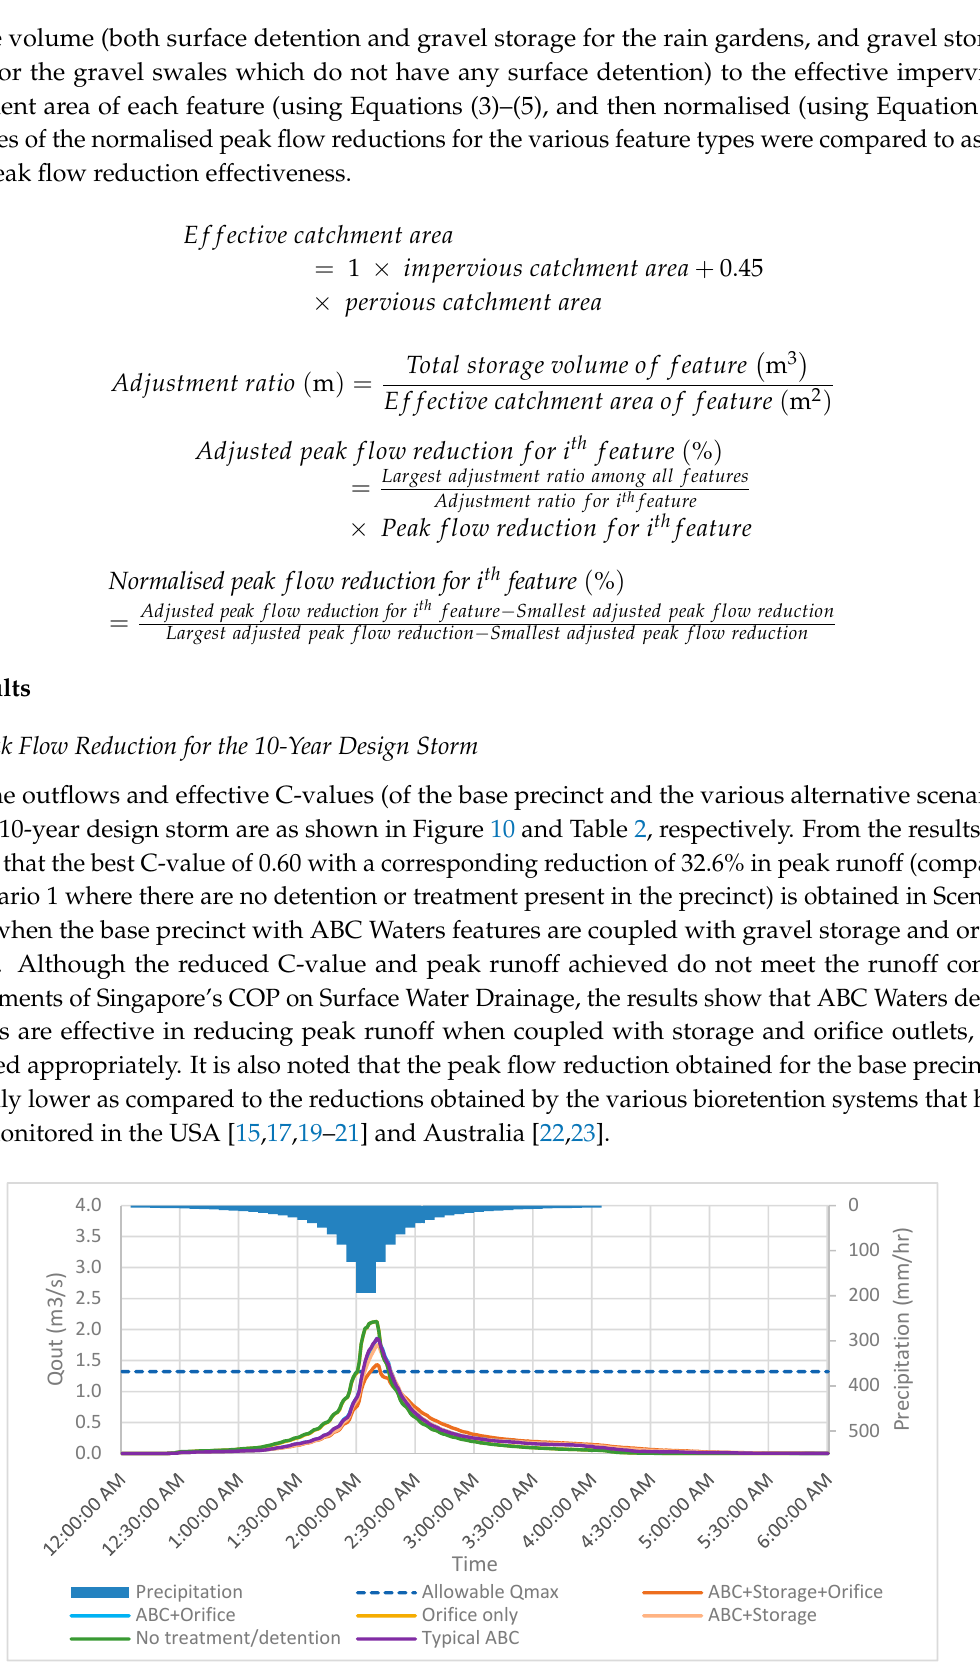
Figure 10. Outflow results of the precinct and alternative scenarios for the 10-year design storm. Table 2. Outflow and effective C-value results of the precinct and alternative scenarios for the 10-year design storm.